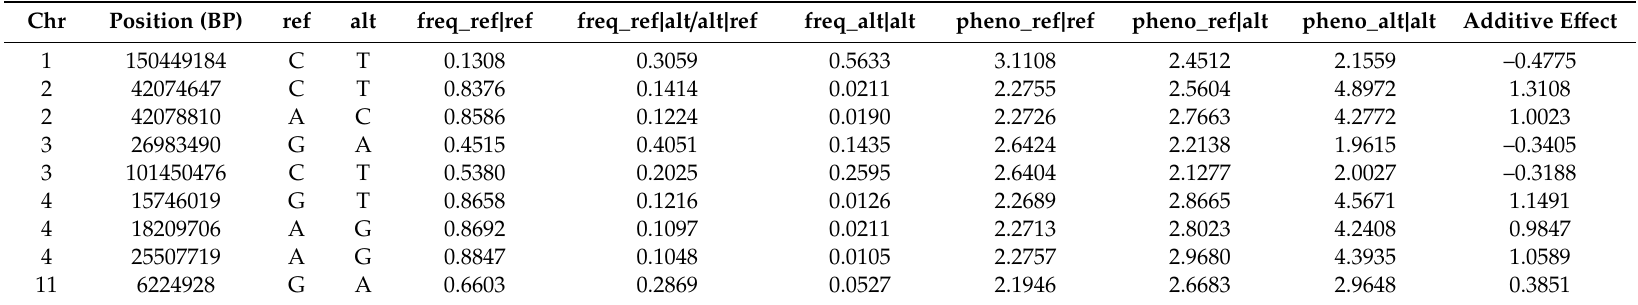
Table 2. Allelic frequency, phenotypic mean, additive e ff ect of significant SNP.